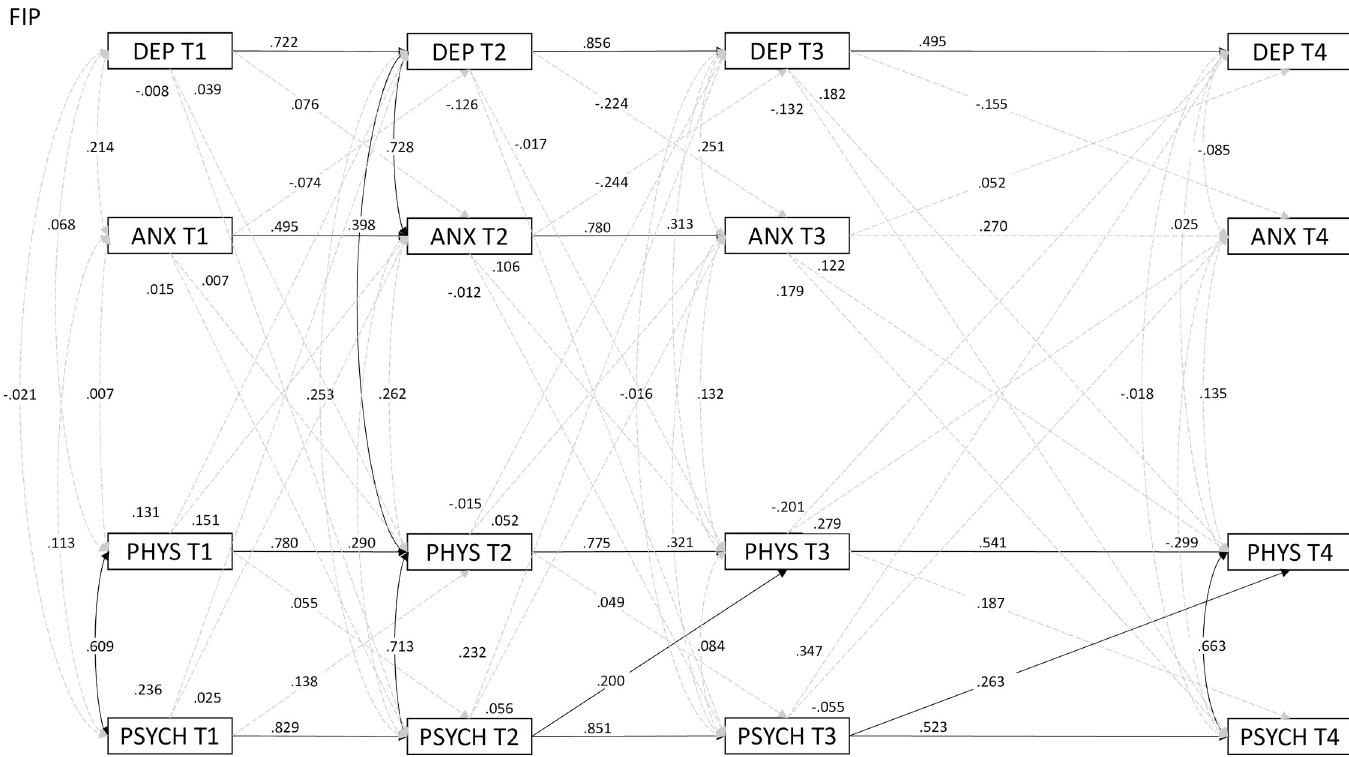
Fig 4. Cross-lagged panel model of MSIS-29 and HADS over four timepoints for FIP ( n = 27). Note : Solid arrows are p < .05; dashed arrows are nonsignificant; numbers above arrows indicate standardized coefficients.